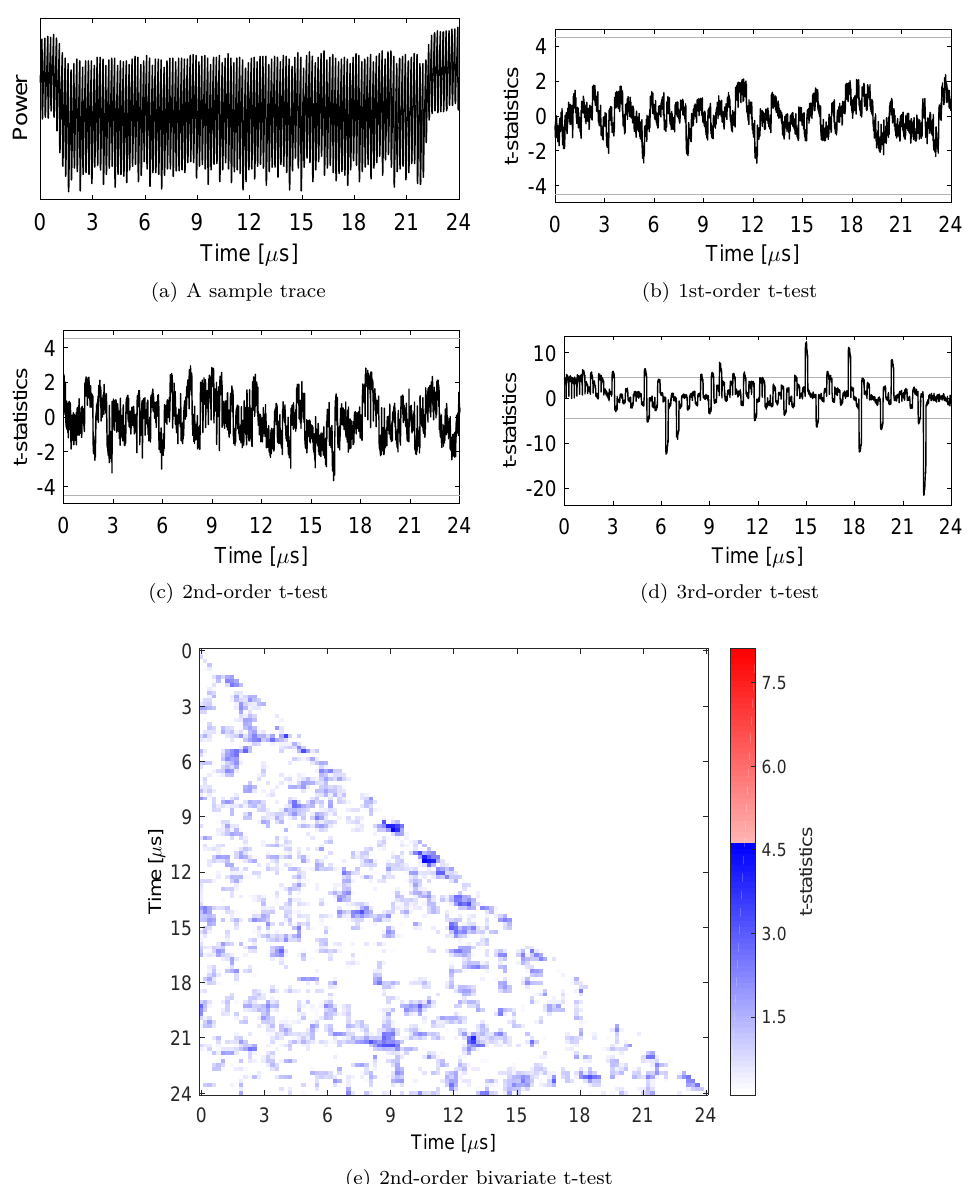
Figure 8: Experimental analysis of our second-order secure round-based SKINNY-64-64 encryption design, 100 million